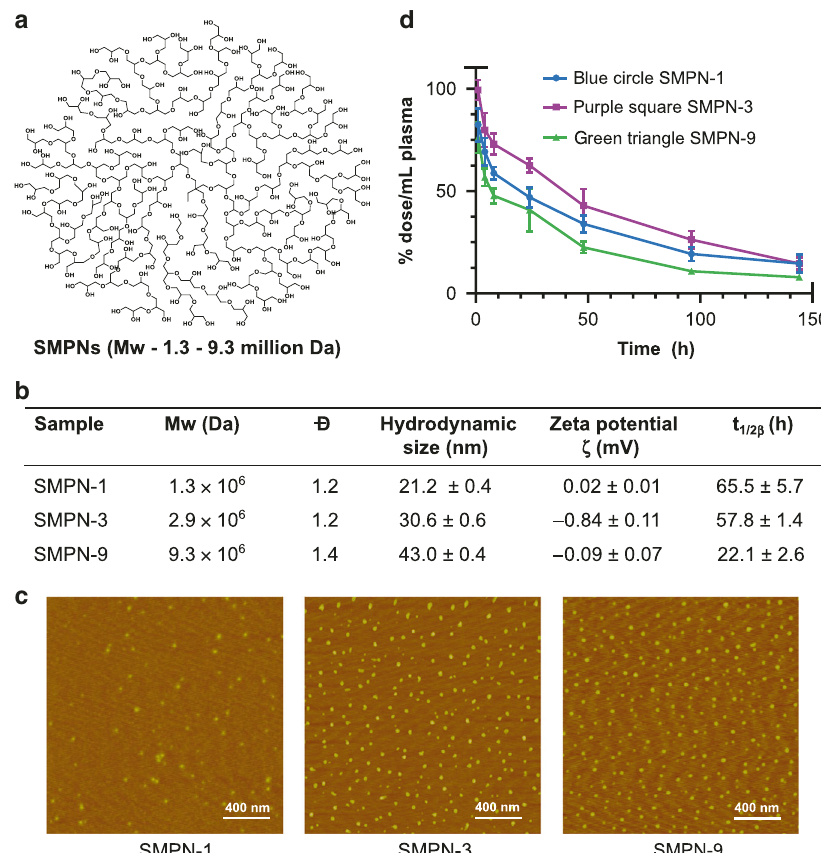
Fig. 1 Design, characterization, and pharmacokinetics of SMPNs. a A schematic representation of SMPNs generated by anionic ring opening polymerization of glycidol. b Physical characteristics, including absolute molecular weight, molecular weight distribution (Ð), hydrodynamic size, and zeta potentials in saline ( n = 3 independent experiments) and circulation half-lives ( t 1/2 β ) of SMPNs based on a two-compartment intravenous bolus model are reported. c Atomic force microscopy images of SMPNs (repeated two times). d Plasma concentration of tritium labeled SMPNs in mice ( n = 4) after intravenous injection is shown. All the data is reported as mean ± s.d. with their respective